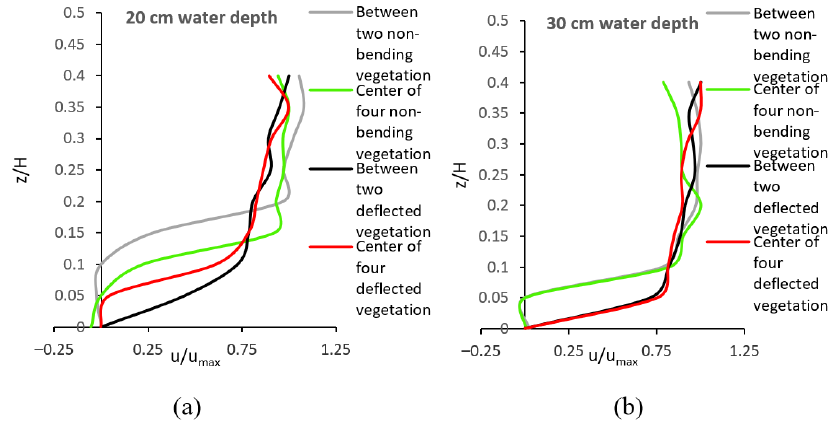
Figure 9. Dimensionless time-averaged streamwise velocity distribution in the presence of square vegetation configuration with a vegetation density of a = 0.624 m − 1 . ADV locations: between two vegetation elements (red circles in Figure 4) and in the center of four vegetation elements (green circles in Figure 4): ( a ) water depth = 20 cm; ( b ) water depth = 30 cm.